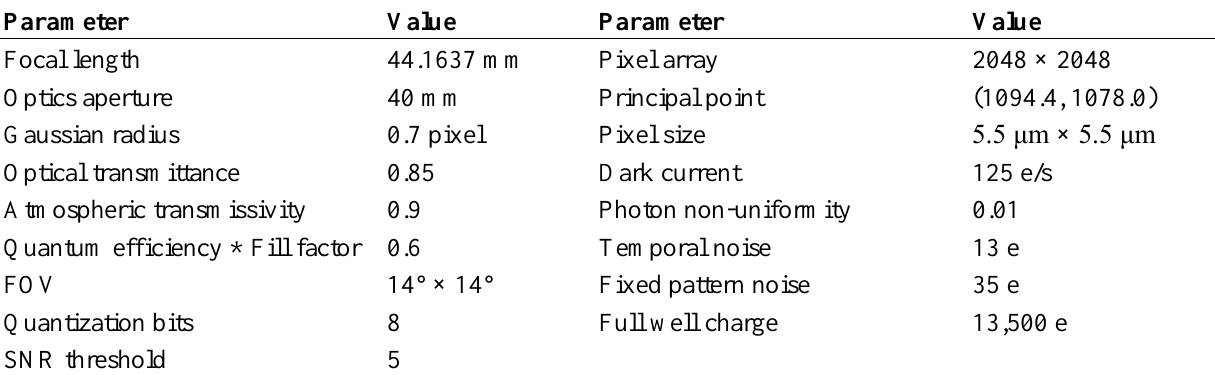
Table 3. Simulation parameters of star tracker with a CMV4000 CMOS image